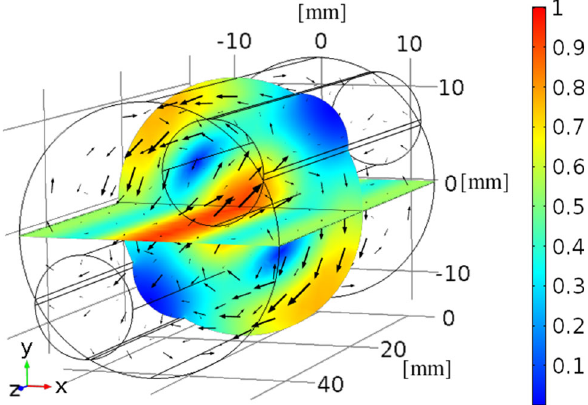
Fig. 3 Design of the microwave cavity and magnetic field distribution of the TM110 mode (see text for details). The black arrows represent the direction of the magnetic field, and the color is the normalized field amplitude. The GaYIG spheres are placed on the cavity axis at the maximum of the rf magnetic field